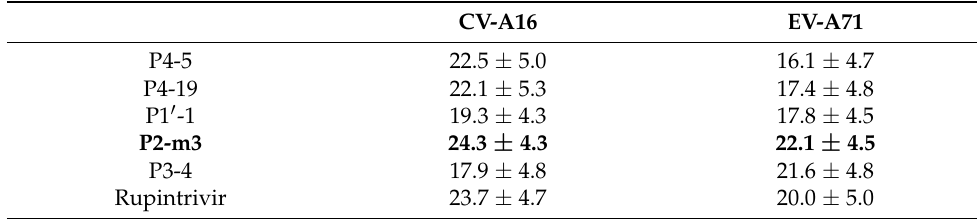
Table 2. Number of contact atoms within the 3.5-Å sphere of the focused compounds for CV-A16 and EV-A71 3Cpro systems taken from the last 50 ns of three independent simulations. The analog with bold was a potent